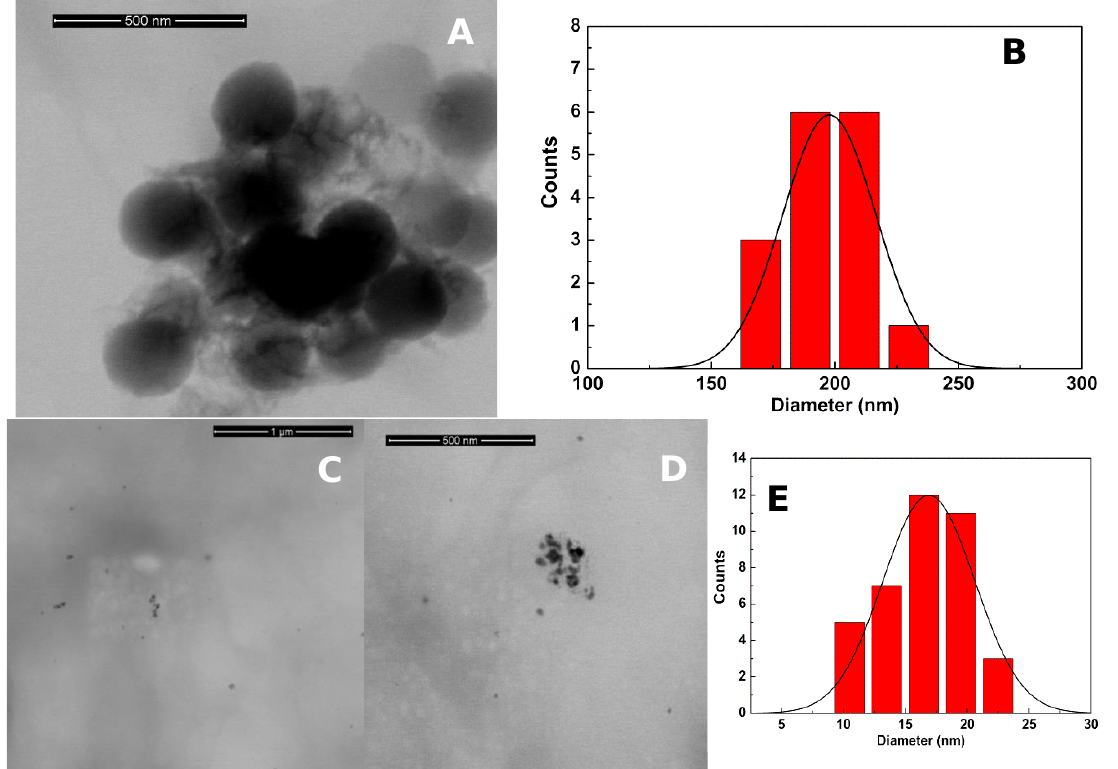
Figure 2. ( A ). SEM image of chitosan nanostructures. ( B ). Size histogram of the chitosan nanoparticles and fitting to a Gaussian distribution. ( C,D ). SEM images of silver nanoparticles embedded in chitosan fibrous structures at different magnifications. ( E ). Size histogram of nanoparticles in the image ( D ) and fitting to a Gaussian distribution.